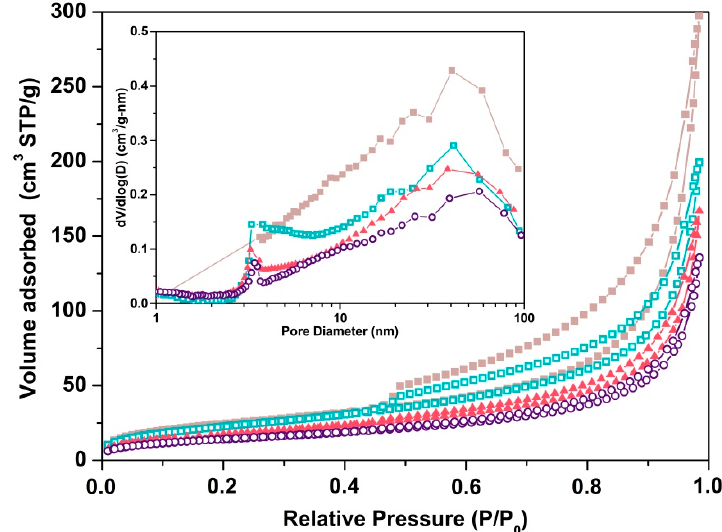
Figure 1. N 2 adsorption/desorption isotherms of AgCdS-T photocatalysts: ( ■ ) T = 90 °C; ( □ ) T = 120 °C; ( ▲ ) T = 150 °C and ( ○ ) T = 190 °C.